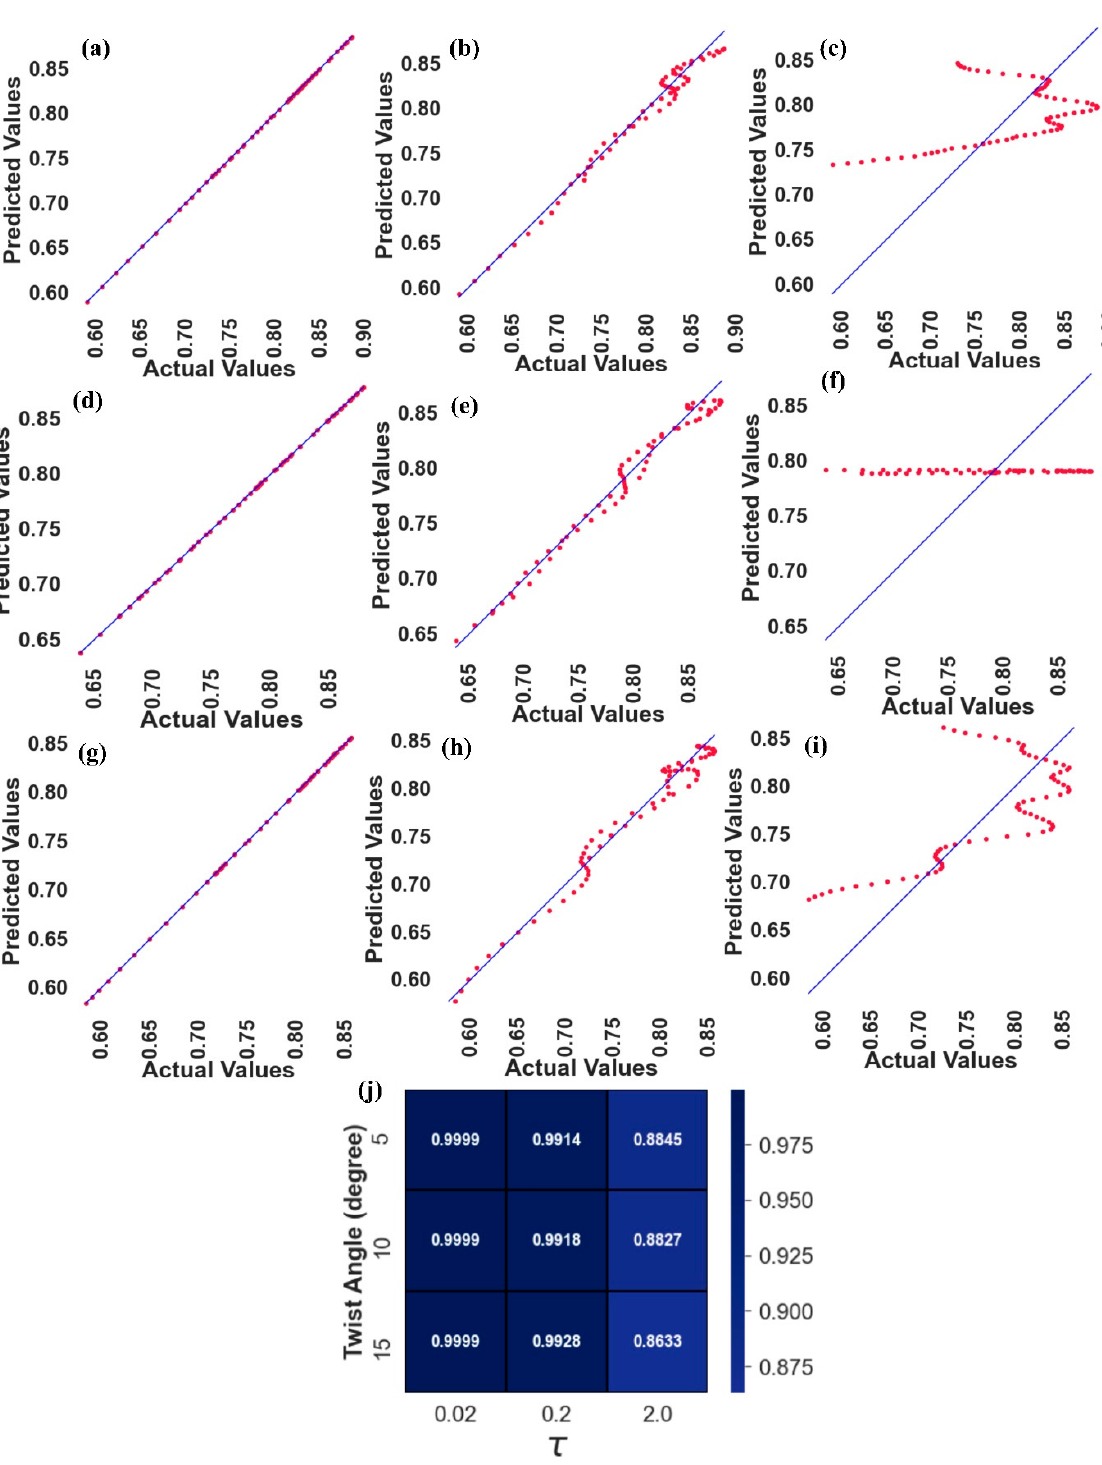
Figure 8. Actual vs. predicted values of absorption for different values of twist angle and hyperparameter: ( a ) for twist angle = 5 ◦ and τ = 0.02, ( b ) for twist angle = 5 ◦ and τ = 0.2, ( c ) for twist angle = 5 ◦ and τ = 2, ( d ) for twist angle = 10 ◦ and τ = 0.02, ( e ) for twist angle = 10 ◦ and τ = 0.2, ( f ) for twist angle = 10 ◦ and τ = 2, ( g ) for twist angle = 15 ◦ and τ = 0.02, ( h ) for twist angle = 15 and τ = 0.2, and ( i ) for twist angle = 15 ◦ and τ = 2. ( j ) Heatmap depicting higher prediction accuracy for τ = 0.02; as we increase it to 2, prediction accuracy